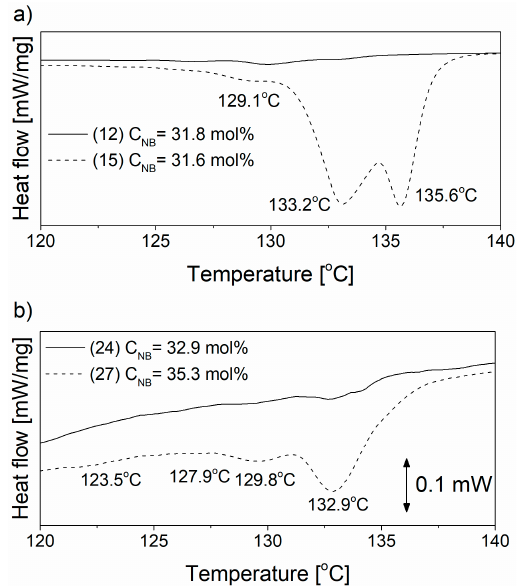
Figure 6. Successive self-nucleation and annealing (SSA) curves of E-NB copolymers obtained by catalysts ( a ) C4 , SIL/C4 and ( b ) C6 , SIL/C6 (items according to Table 1).